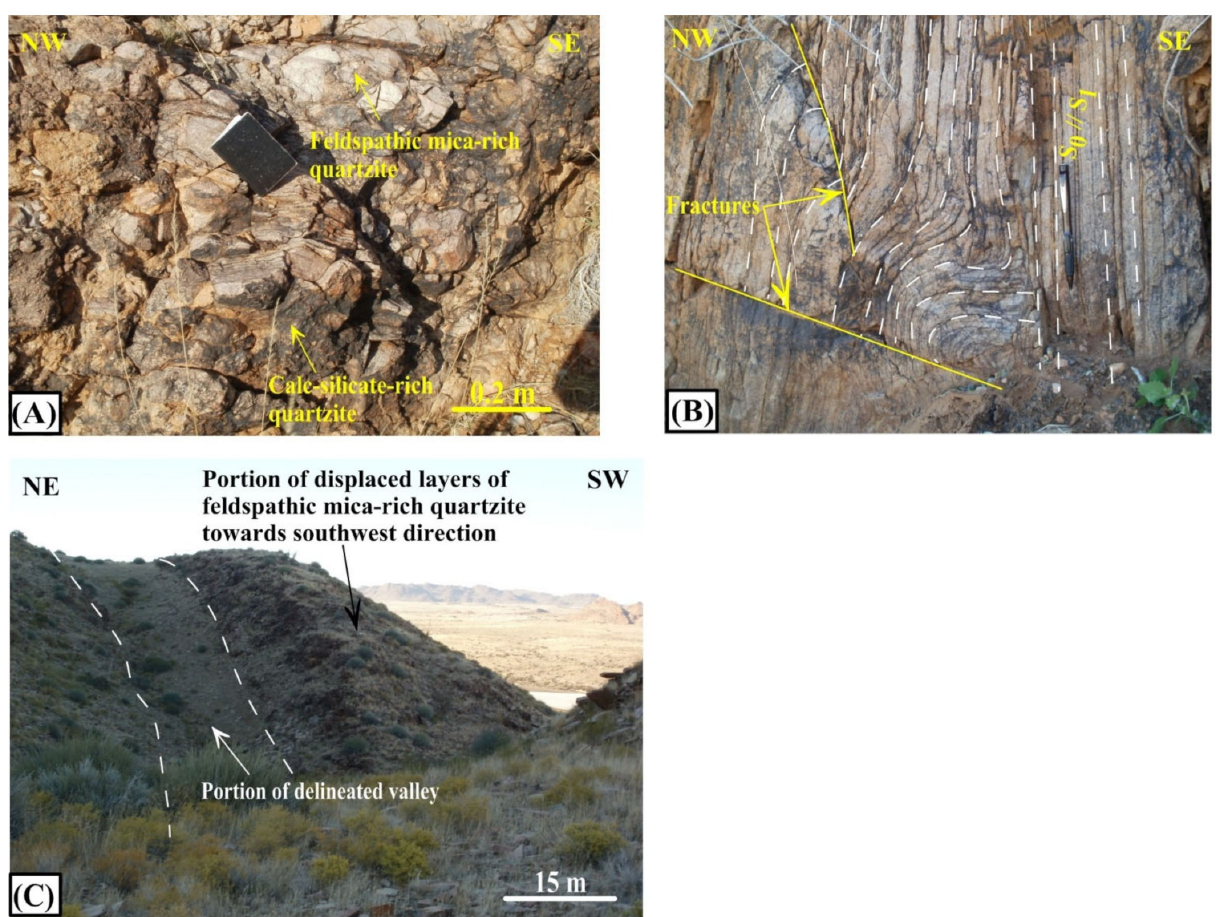
Figure 9. ( A ) Breccia in the Neusberg Thrust showing a mixture of fragments of feldspathic mica-rich quartzite and calc-silicate-rich quartzite. ( B ) Steep to overturned and extensively deformed layers of feldspathic mica-rich quartzite in the Neusberg Thrust. ( C ) A portion of the valley along the Neusberg Thrust. The direction of view is towards the